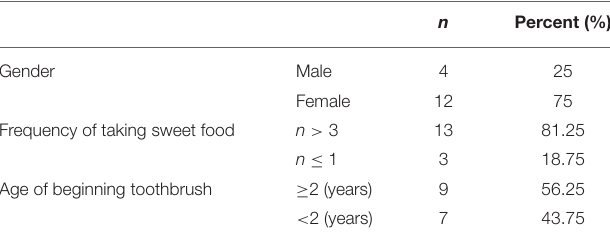
TABLE 3 | Environmental factors related with